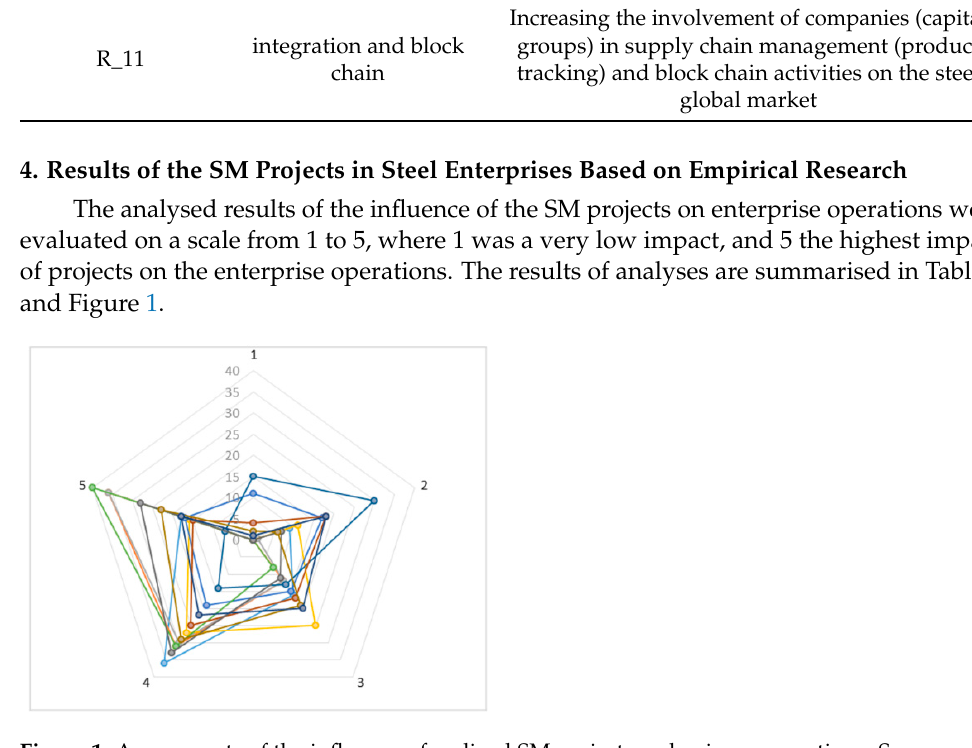
Figure 1. Assessments of the influence of realized SM projects on business operations. Source: own research [73].